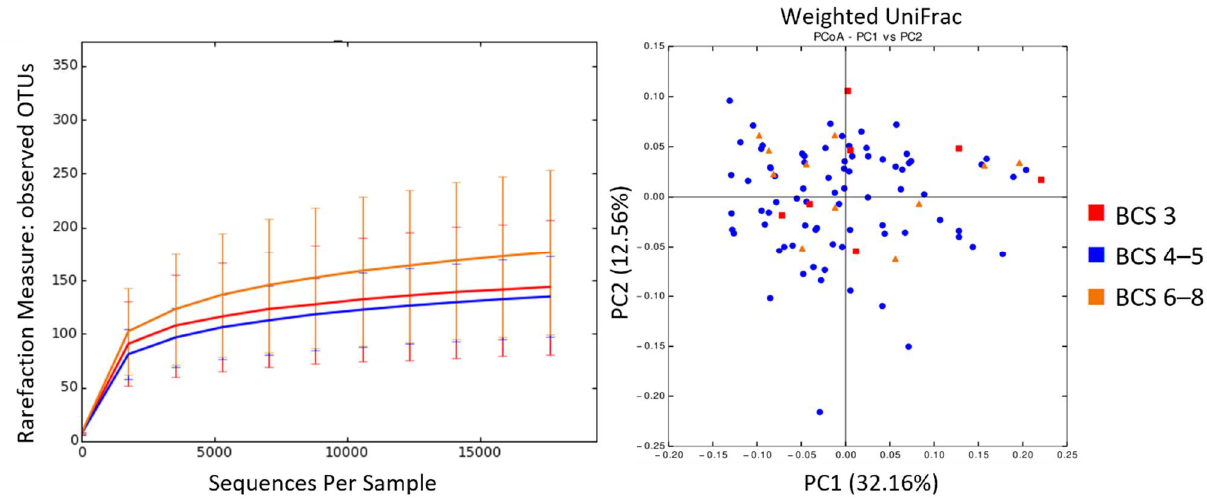
Figure 6. Alpha and beta diversity according to dog BCS groups. Microbial richness was measured based on observed OTUs ( left ). PCoA was performed based on weighted UniFrac distances ( right ).